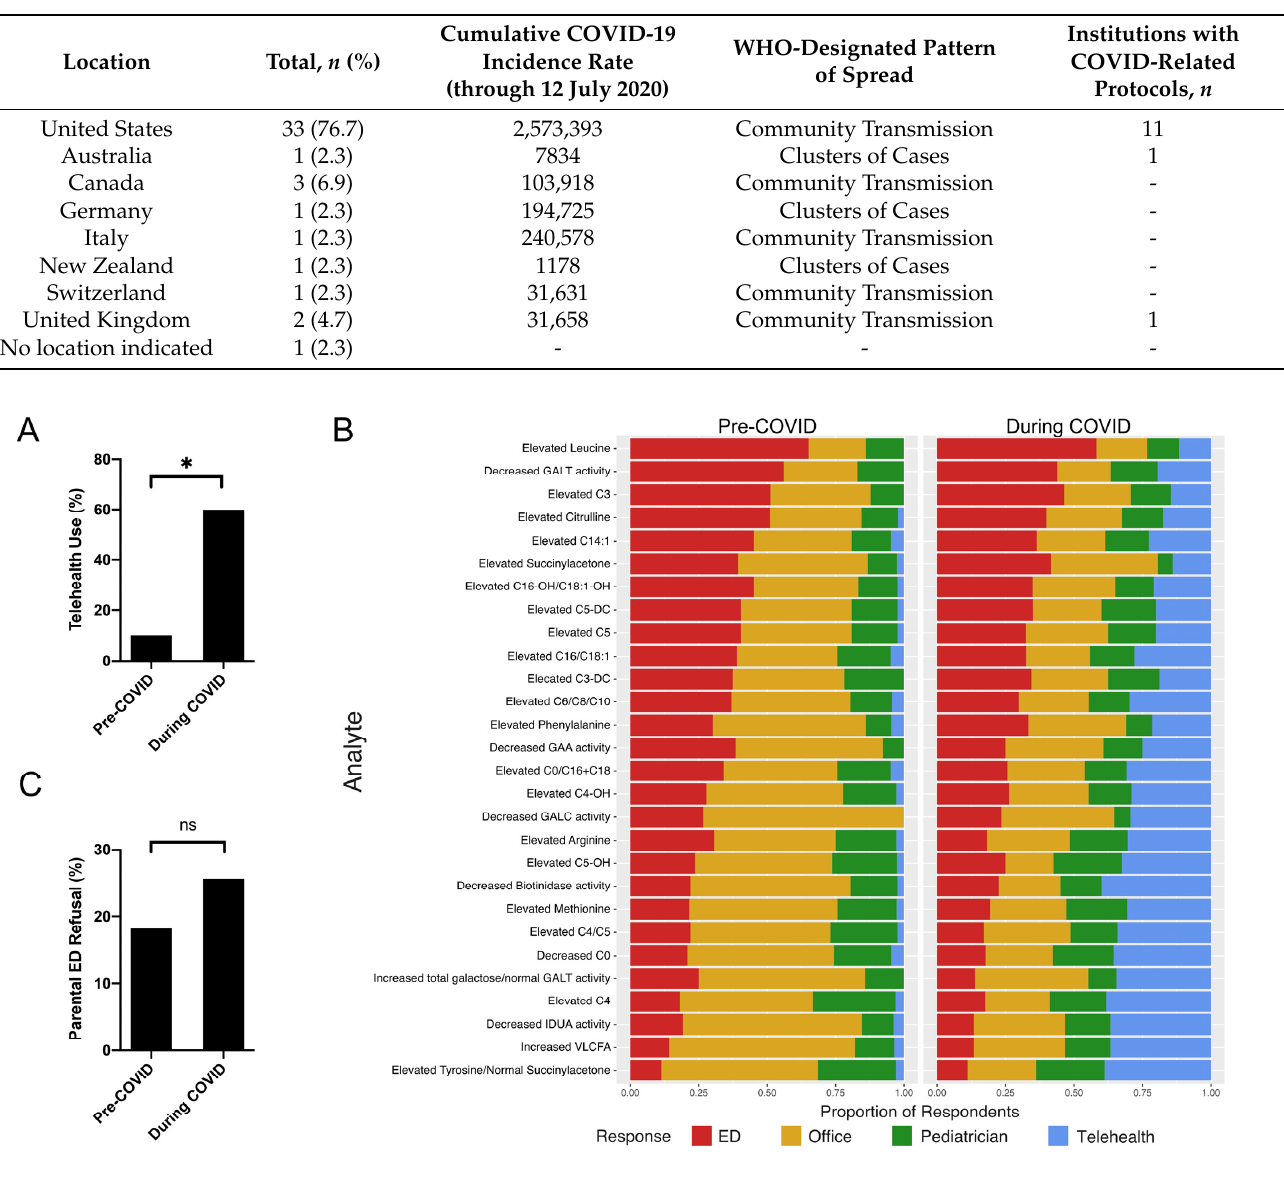
Figure 1. COVID-19 led to an increase in telehealth use for NBS referrals. ( A ) Use of telehealth for NBS follow-up significantly increased during March–June 2020, corresponding with the first wave of COVID-19. * p < 0.0001 ( B ) Respondents reported their referral pattern for NBS analytes pre-pandemic ( left ) and during the pandemic ( right ). Telehealth use increased for all analytes and primarily replaced in-person visits to metabolism clinic. ( C ) Providers did not report any significant difference in parental refusal to present to the Emergency Department (ED) for NBS follow-up. p = 0.41. ED: Emergency